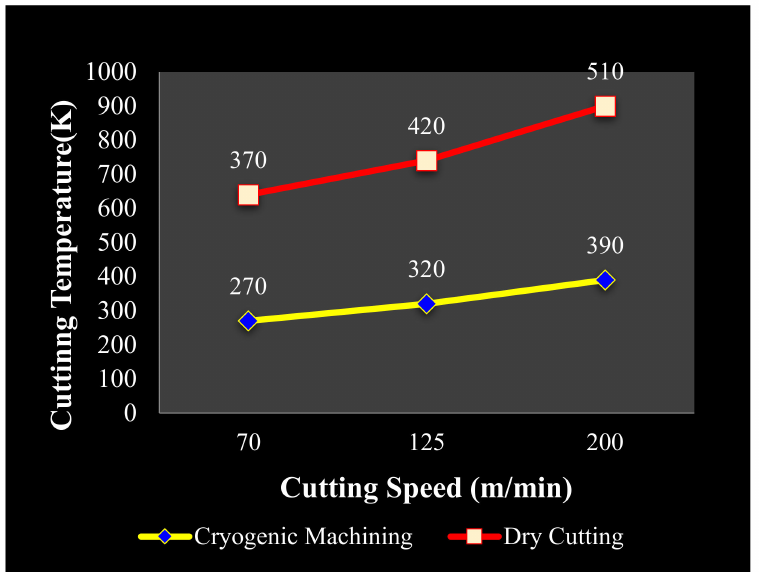
Figure 23. Effect of two cooling techniques on cutting Temperature, reprinted with permission from ref. [95]. Copyright 2018 Elsevier